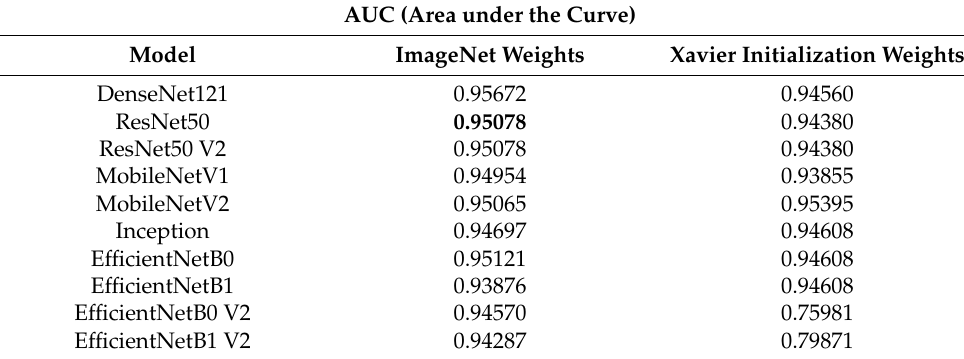
Table 3. Model architectures analysis results.